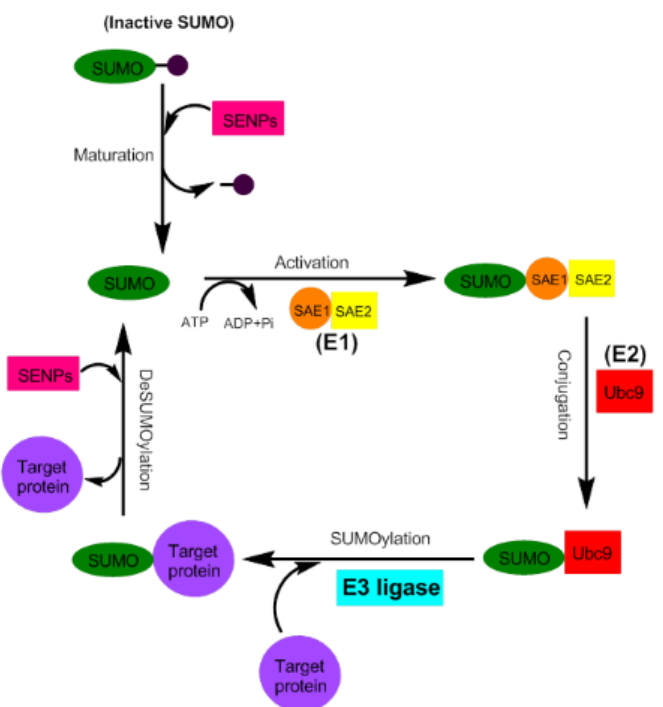
Figure 1. Schematic summary of the SUMOylation pathway. The precursor of small ubiquitin-like modifier (SUMO) is matured by a member of the sentrin-specific protease (SENP) family. This form has a C-terminal di-glycine motif. SUMO is then activated by E1 enzyme, a heterodimer of Aos1 and Uba2. Activated SUMO is passed to the active site of E2 conjugation enzyme, Ubc9. Finally, SUMO is transferred with E3 ligase to the target protein. DeSUMOylation of the substrate is caused by SENP family proteases.